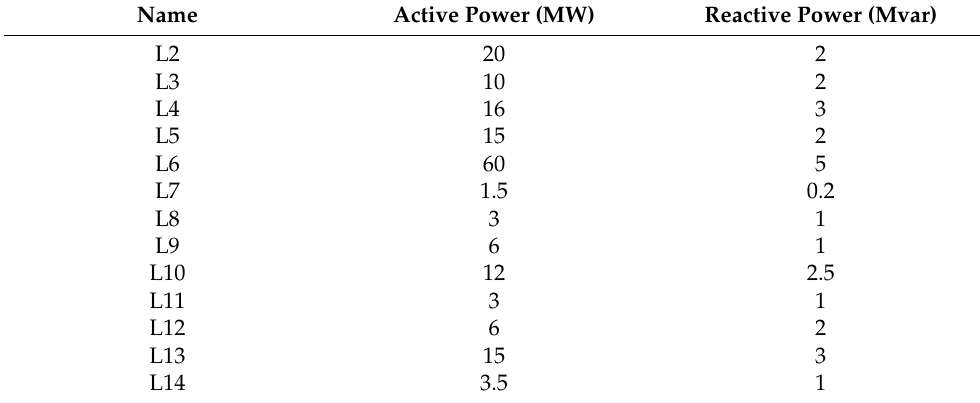
Table 8. Electric